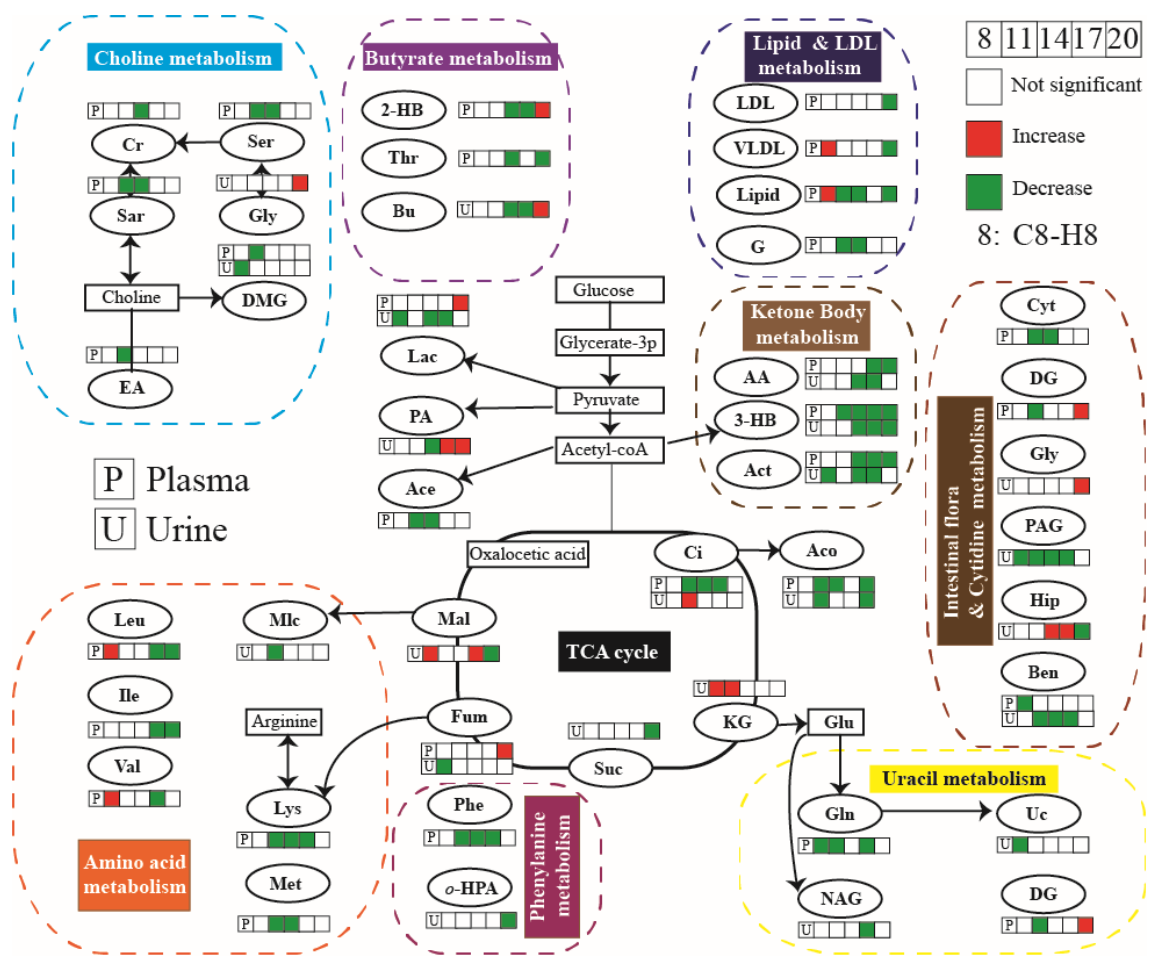
Figure 8. Metabolic pathway of maternal rat affected by hypoxia during